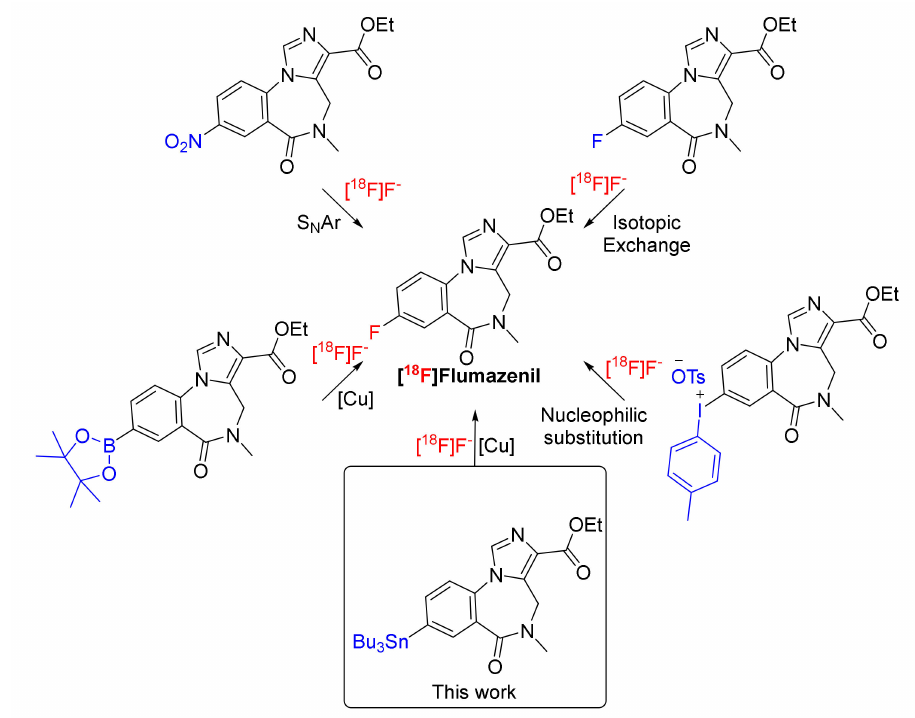
Figure 1. Nucleophilic radiofluorination methods for the preparation of [ 18 F]flumazenil 1 . Windhorst and co-workers initially reported the radiosynthesis of [ 18 F]FMZ 1 by the substitution of the nitro group of nitromazenil or by the isotopic exchange (F-19 substi- tuted by F-18) of flumazenil 1 (Figure 1) [18]. The radiofluorination was performed at an elevated temperature ( ≥ 130 ◦ C), a reduced pressure ( ≤ 0.8 bar) and with the use of 2,4,6-trimethylpyridine as solvent. These harsh conditions afforded a moderate (44% yield by isotopic exchange) to low yield ( ≤ 12% yield by nitro substitution). Furthermore, the method using an isotopic exchange afforded [ 18 F]FMZ 1 with a low molar activity (the ratio of the quantity of F-18-labeled molecules to the total quantity of FMZ (i.e., containing either F-18 or F-19)) [19]. The preparation of [ 18 F]FMZ 1 by isotopic exchange was further